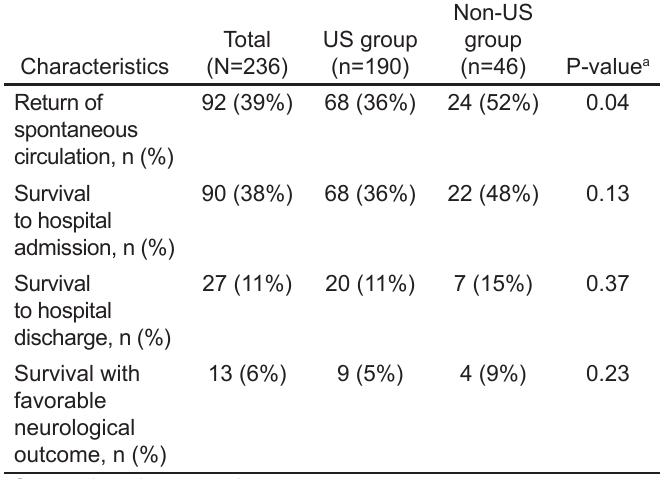
Table 4. Resuscitation